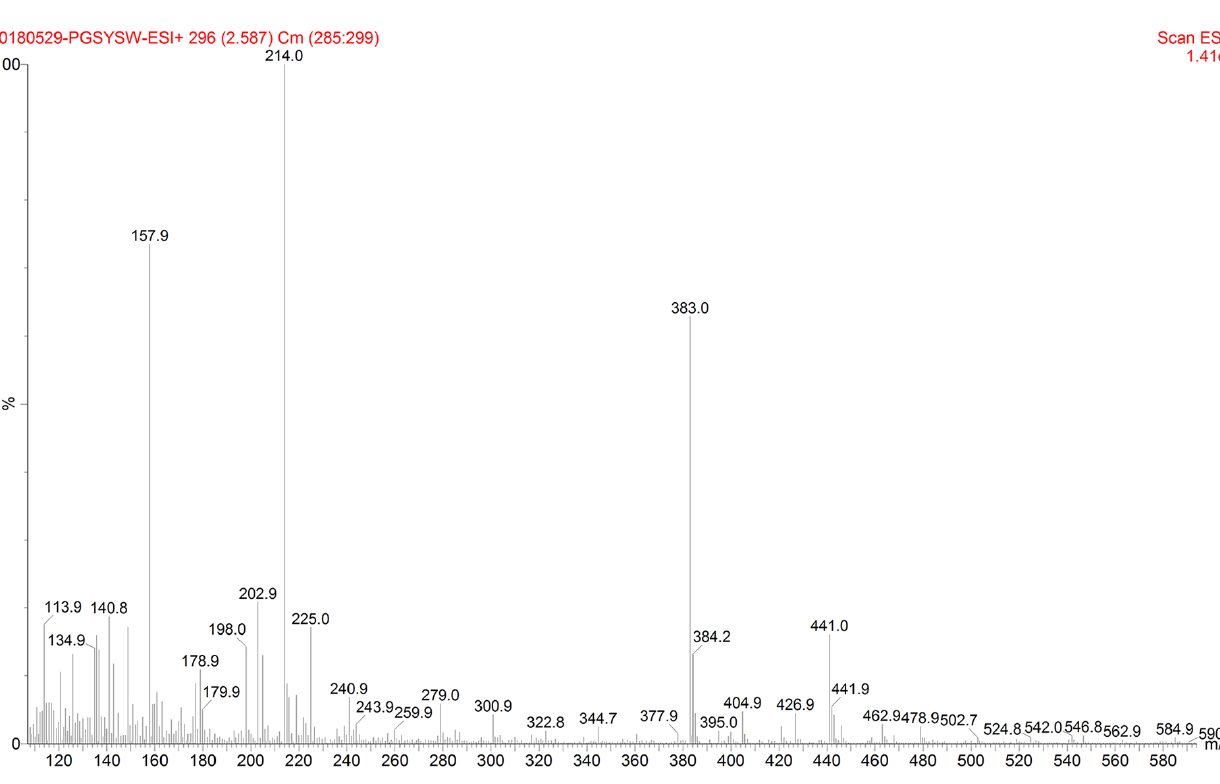
FIGURE 2 - The mass spectrum for derivatives of DL-malic acid.